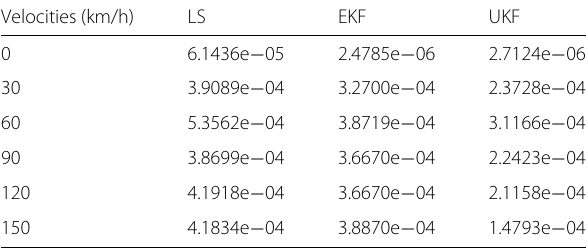
Table 2 The variance for BEM-based channel estimation methods in different velocity Velocities (km/h)